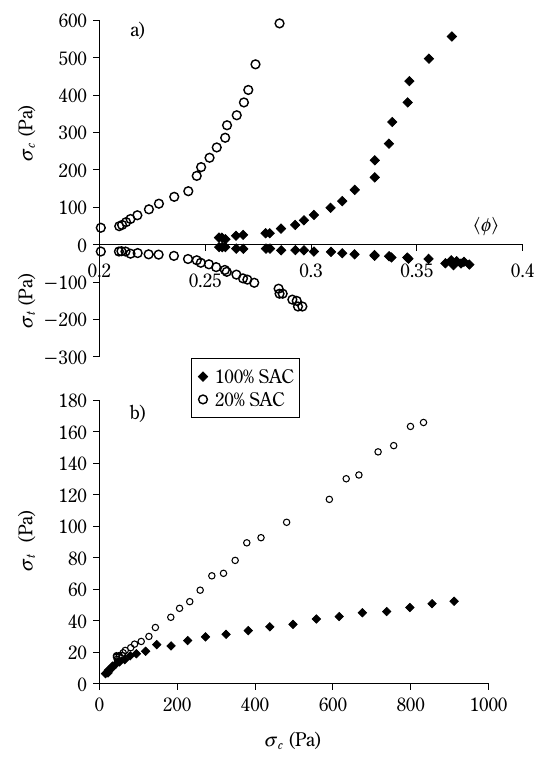
(a) Relationship between the average particle volume fraction (cid:2) f (cid:3) , uniaxial tensile yield stress s t and consolida- tion stress s c as measured by the SPT. (b) Tensile yield stress as a function of the consolidation stress. Results for two xerographic toners of (cid:8) 7 µ m particle size and with different surface additive coverage (SAC) levels are